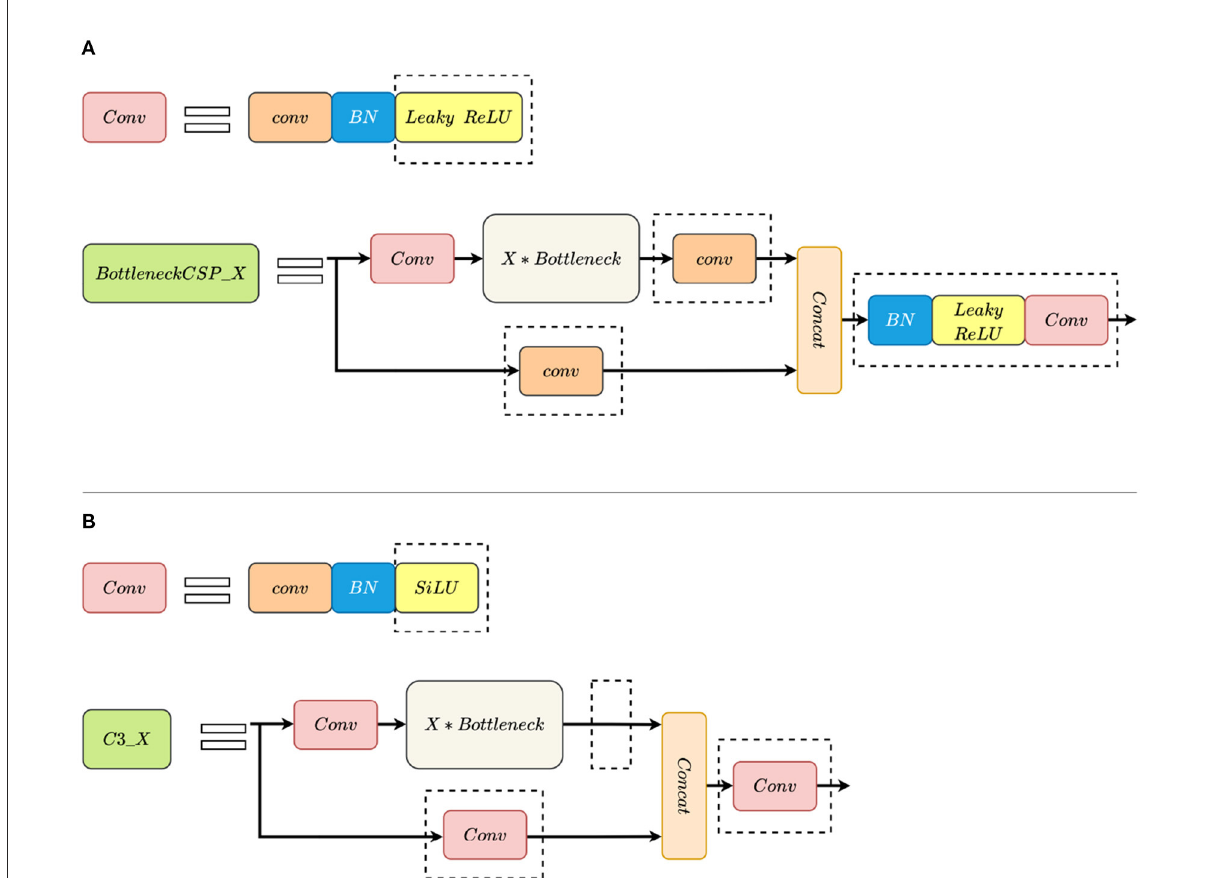
FIGURE1 Comparison between BottleneckCSP_X and C3_X modules. (A) BottleneckCSP_X. (B) C3_X. The dotted rectangle indicates the difference between them. SiLU replaces leaky ReLU. C3_X removes Conv after Bottleneck and replaces Conv in another path with Conv. Additionally, it abandons BN and Leaky ReLU after concatenating the output data from two